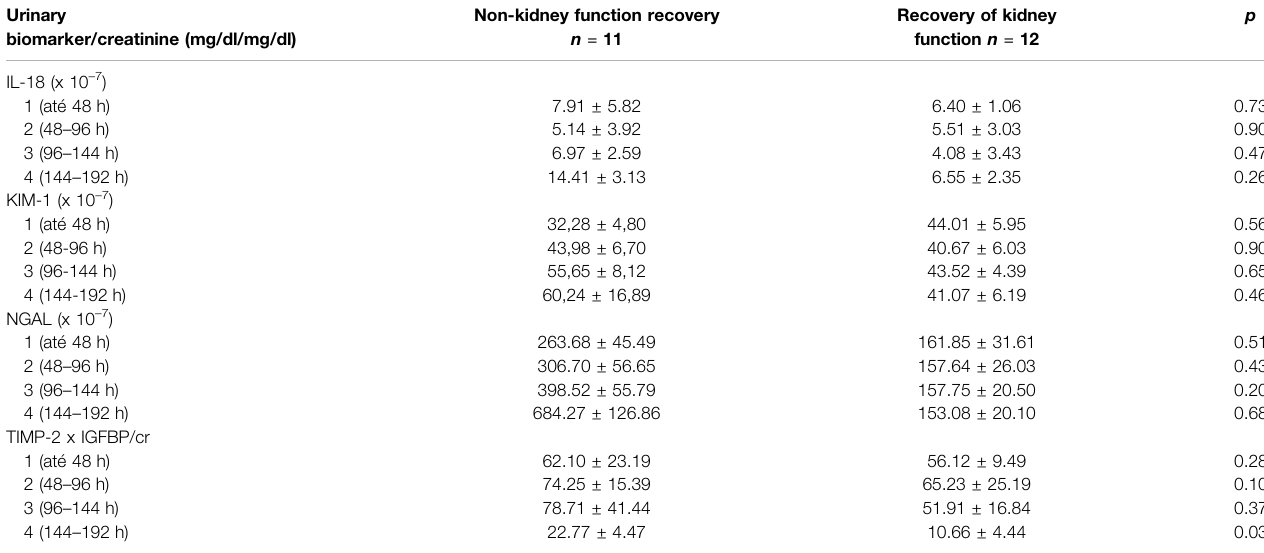
TABLE 7| Urinary biomarkersvaluesnormalized forurinarycreatinineaccordingtotherecoveryofkidneyfunctionatdischarge hospitalinpatientshospitalizedinwards and receiving vancomycin. Urinary biomarker/creatinine (mg/dl/mg/dl)